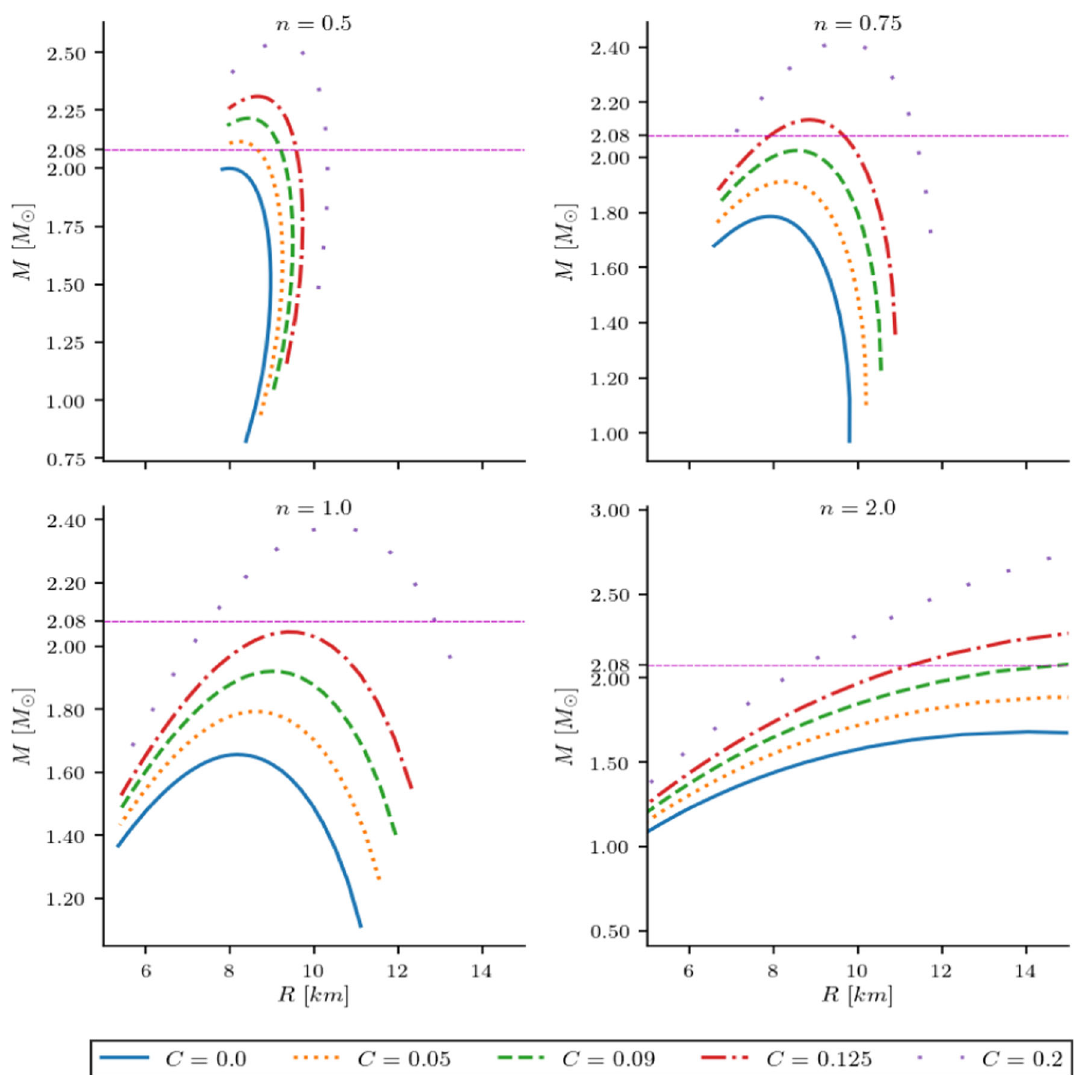
Fig. 6 Total mass-total radius curves, M − R , for models with α = − 0 . 01, (cid:18) = 0 . 17, and varying C (the anisotropic factor) for several values of the polytropic index n . The curves appearance are highly related to the polytropic index n , and are sensitive to variations in the